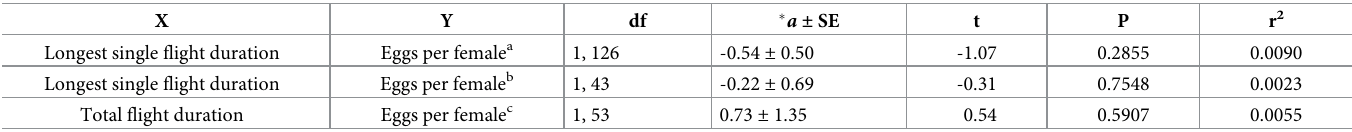
Table 3. Summary of linear regression analyses of flight vs.